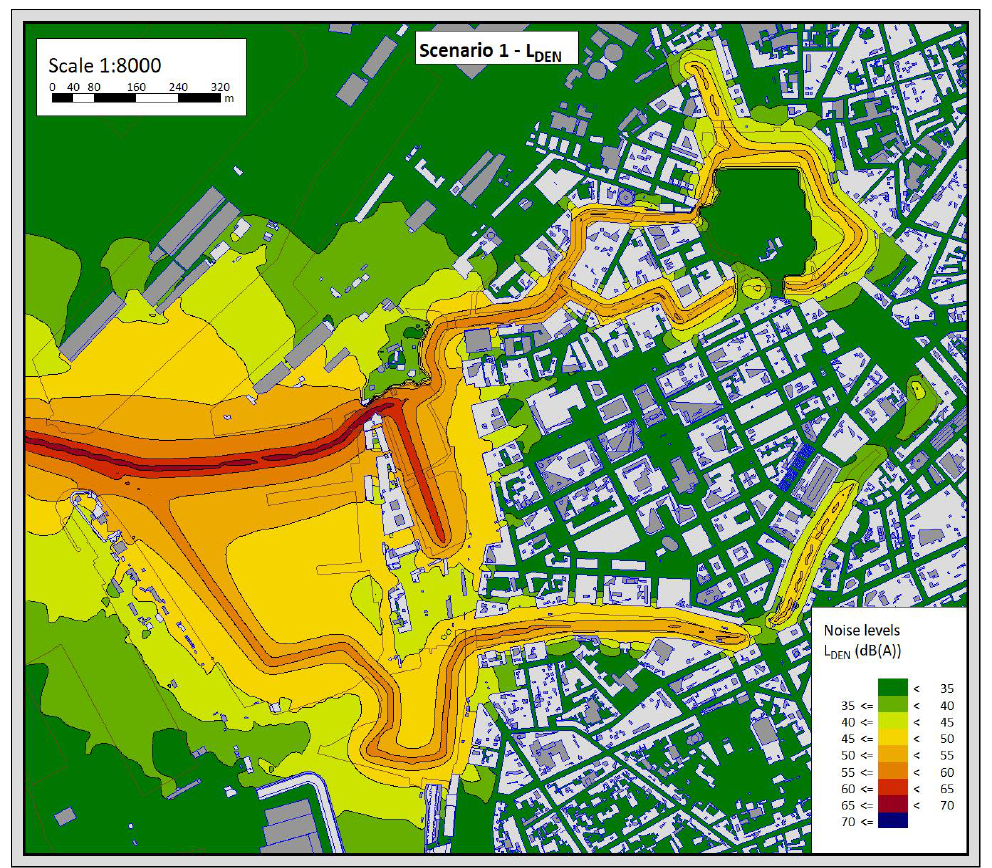
Figure 5. L DEN noise contours map for Scenario 1 (present).